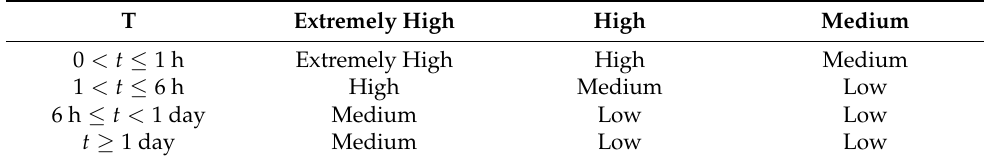
Figure 6. Divide the enclosed space into grids. “H” means high risk level, and “M” means medium risk level. Table 4. The principles of risk level changes.